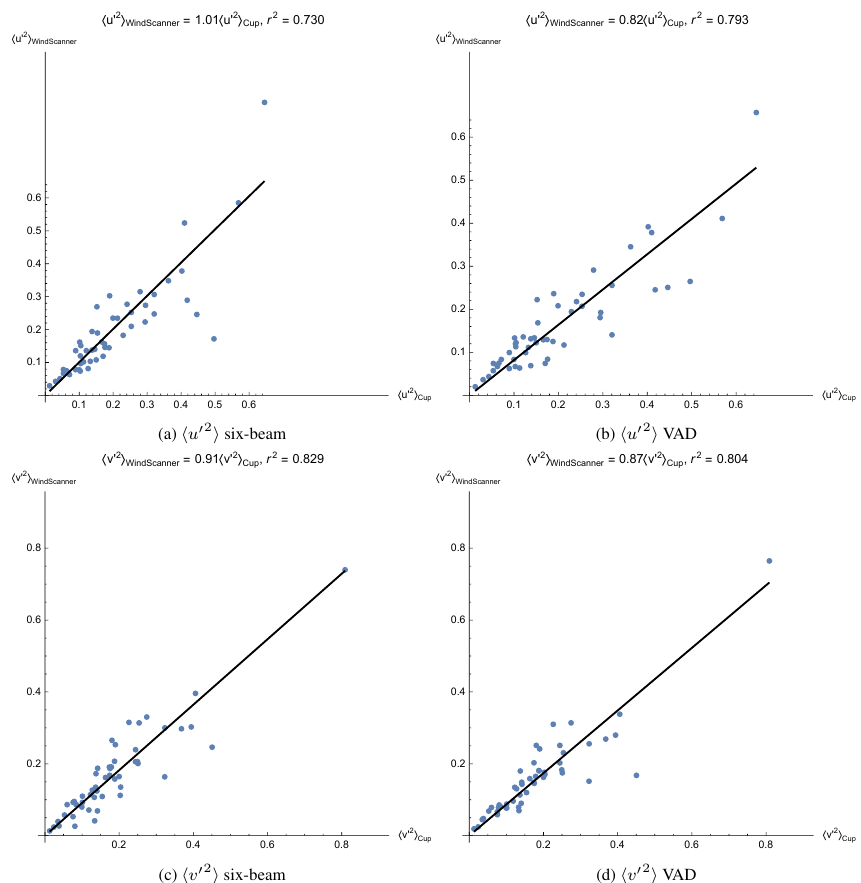
Figure 7. Comparison of the turbulence statistics under stable conditions between the WindScanner and the cup anemometer using two Fig. 7: Comparison of the the turbulence statistics under stable conditions between the WindScanner methods. and the cup anemometer using two methods